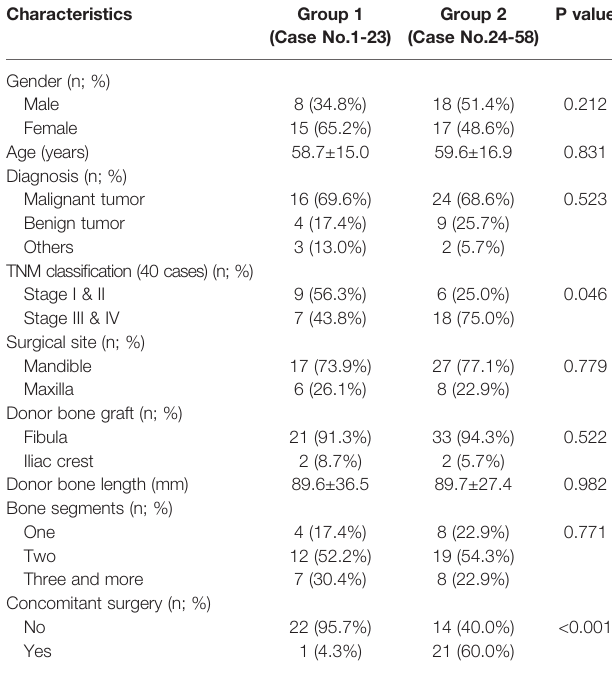
TABLE 3 | Comparison of baseline characteristics among chronological 2